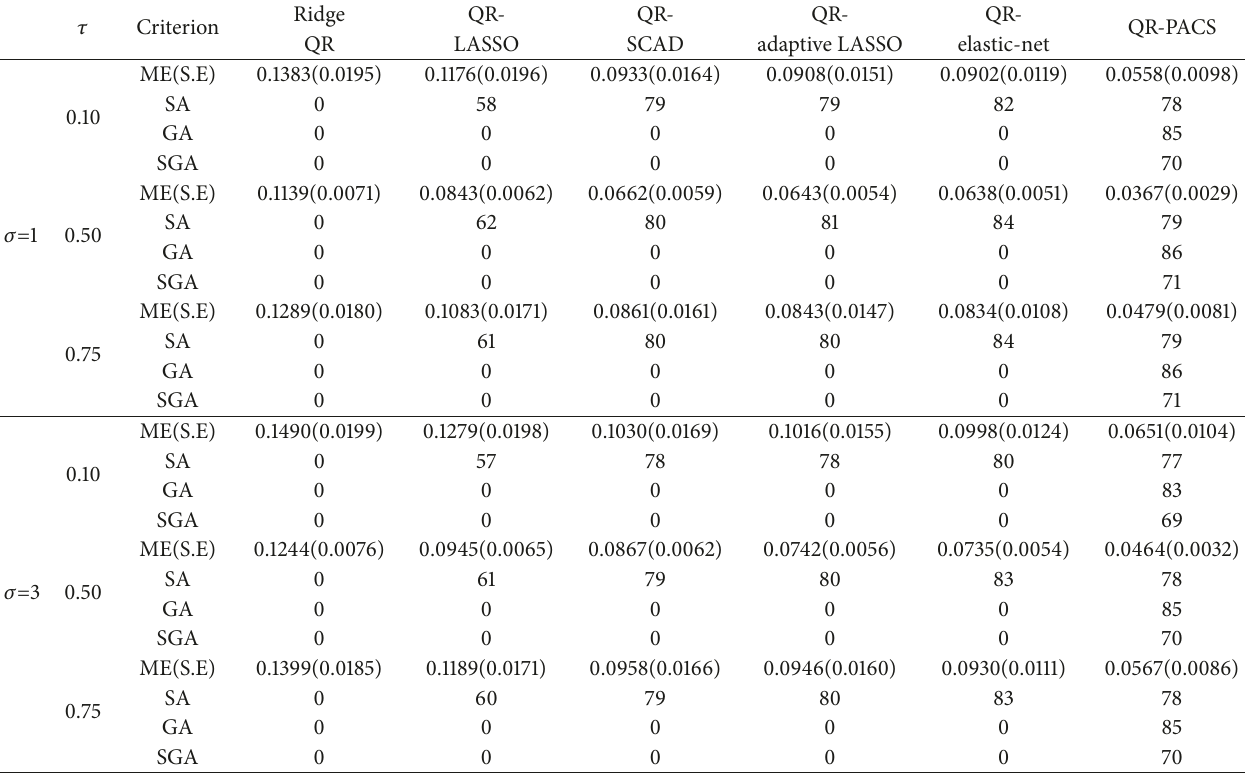
Table 3: ME, SA, GA, and SGA results of Example 3 for n=100.